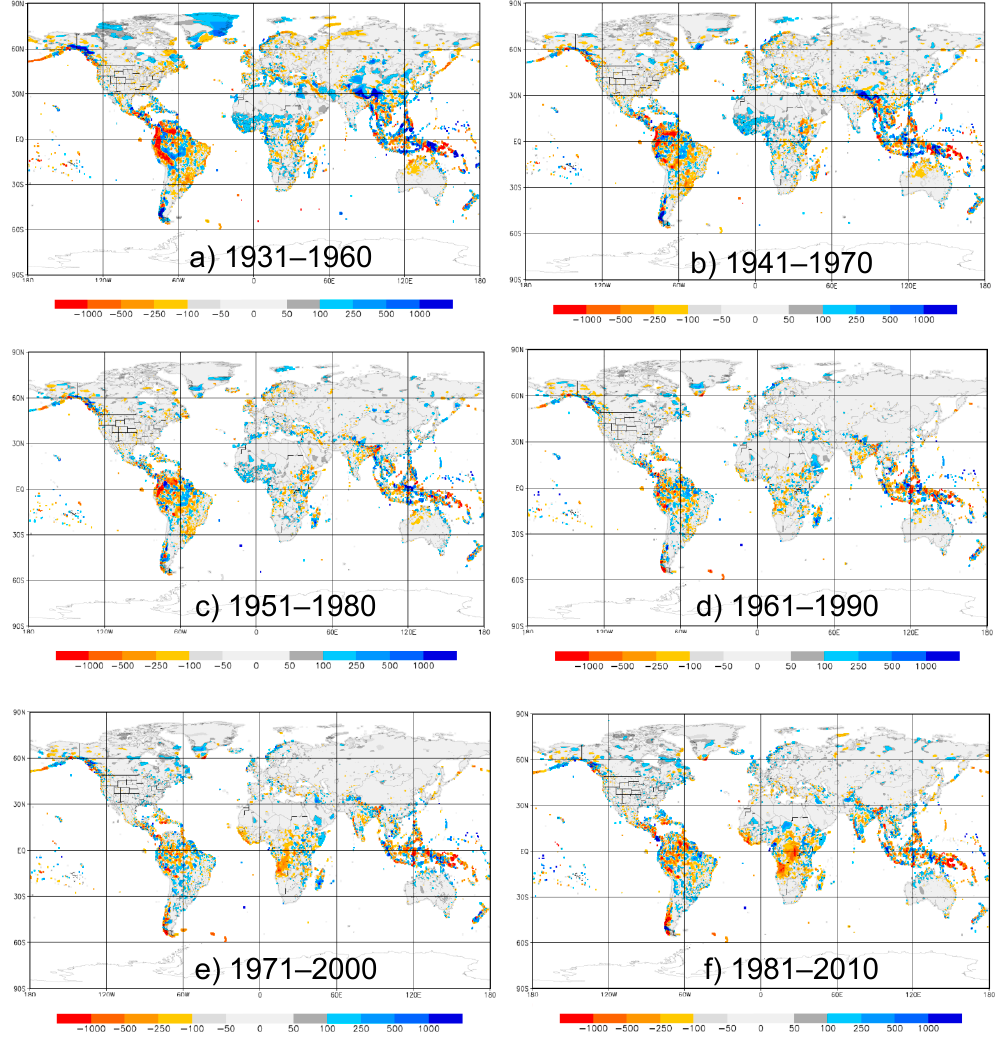
Figure 5. Differences between mean annual precipitation for the different 30-year reference periods ( a ) 1931–1960; ( b ) 1941–1970; ( c ) 1951–1980; ( d ) 1961–1990; ( e ) 1971–2000 and ( f ) 1981–2010 to GPCC’s precipitation climatology 1951–2000